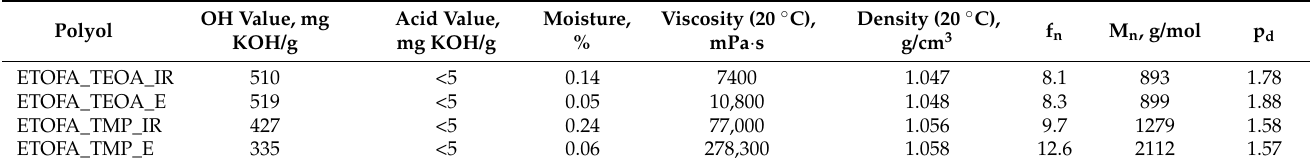
Table 3. Common characteristics of developed tall oil fatty acids (TOFA)-based